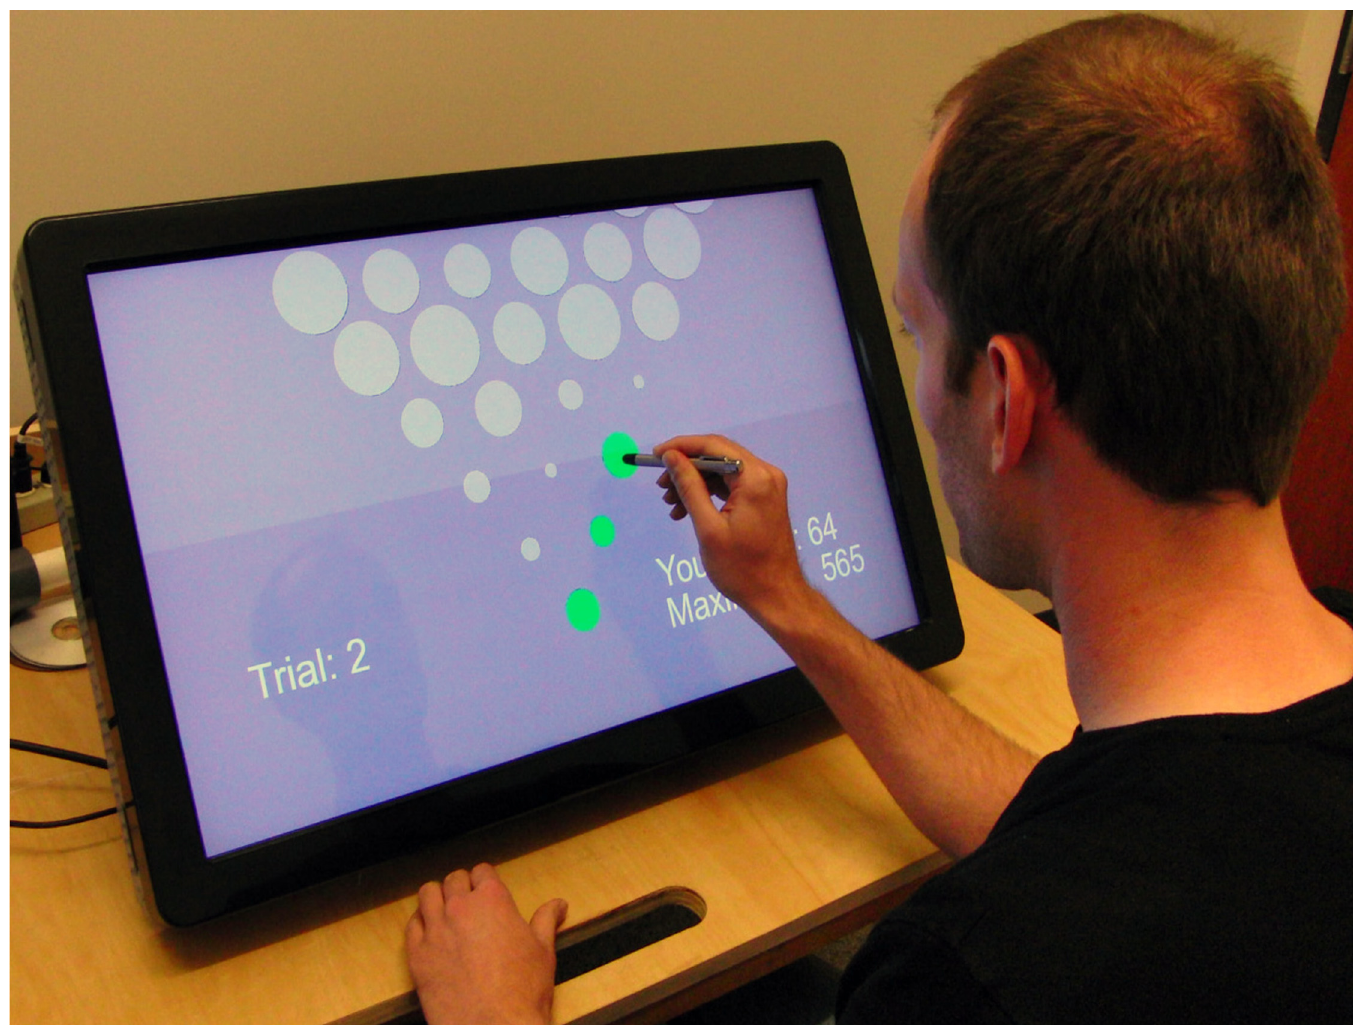
Fig 2. Participant performing the task. The stimulus is a triangular lattice of disks of different sizes scrolling down on a touch-sensitive screen. The task is to collect maximal score by touching the disks: the larger the disk the larger the score. On every step, the participant makes a binary choice; only one of the two adjacent disks may be touched above the just-touched